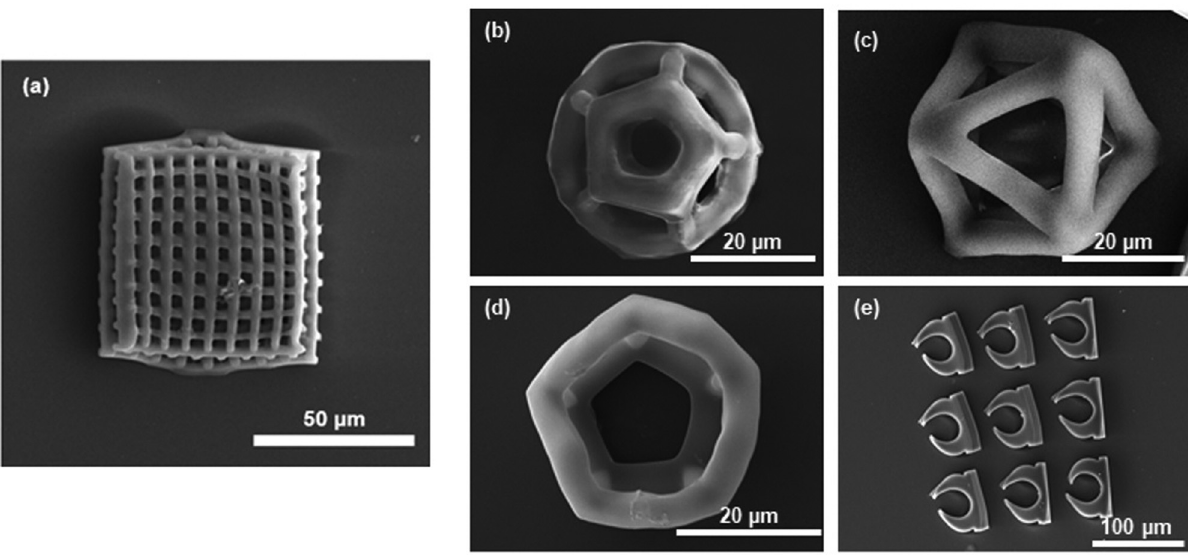
Figure 6: SEM images of the AuNR/LCE micro - structure fabricated by TPP DLW: ( a ) woodpile structure; frame structures of ( b ) regular dodecahedron, ( c ) octahedron and ( d ) pentagon cylinder; and ( e ) micro -